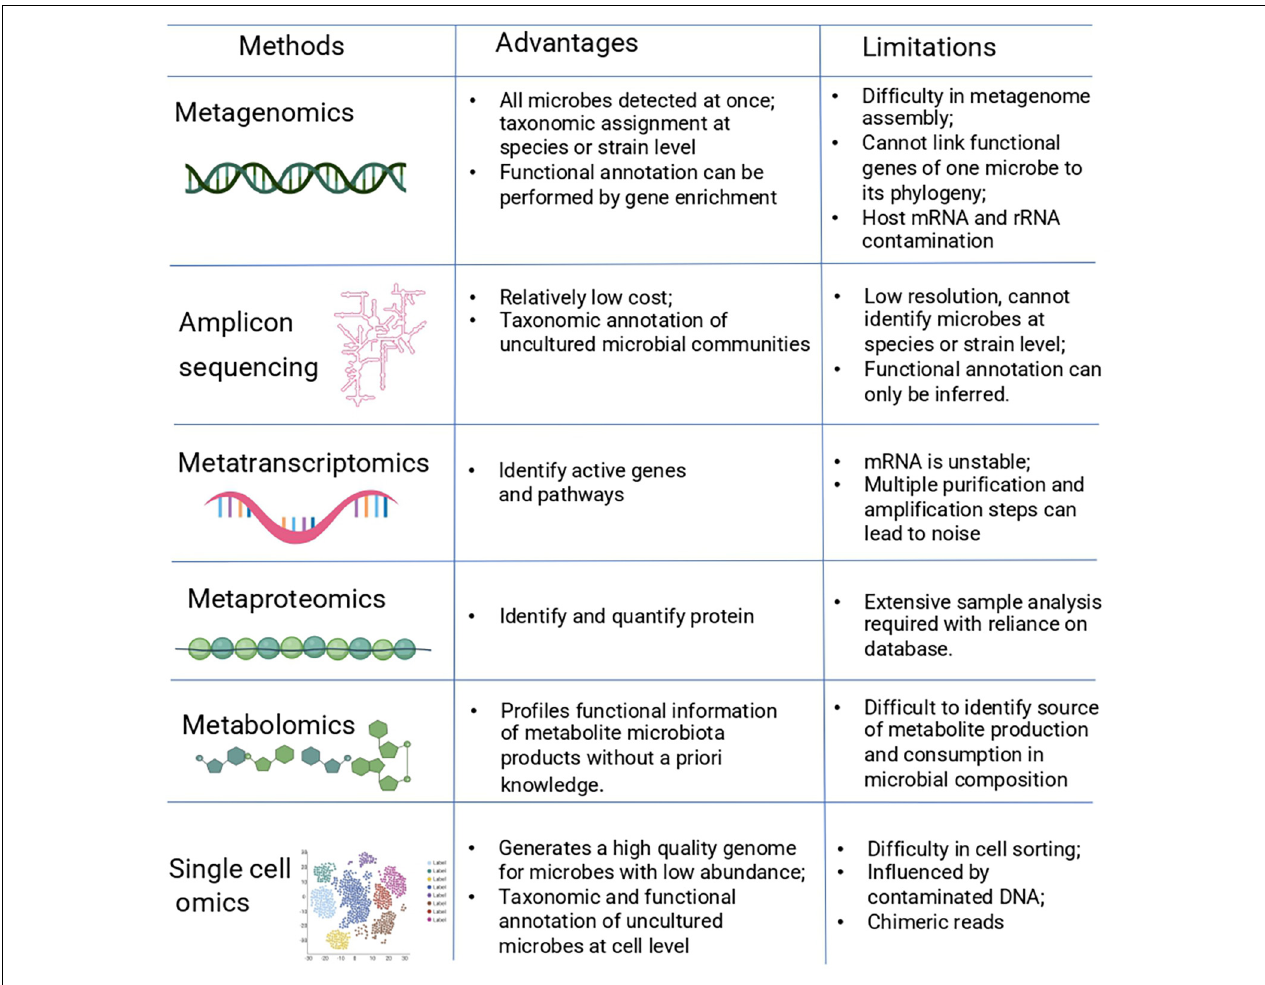
FIGURE 4 | Potential application of diagnostics and therapeutics for human microbiome research. Top panel shows how synthetic biology enables the design of biosensors. This biosensor is a molecular module that can sense and process a biological signal which can be read by a diagnostic device. The middle panel shows different approaches of how the microbiome can be edited by supplementing the communities with certain bacteria that leads to enrichment of bacteria in the community. Colonization of the microbial community with engineered bacteria can lead to the production of certain compounds. Targeting specific bacterial species can selectively eliminate deleterious metabolites from the microbiota. The bottom panel show how a genetic circuit can be engineered and incorporated in a vector that can either diagnose and/or release the therapeutic